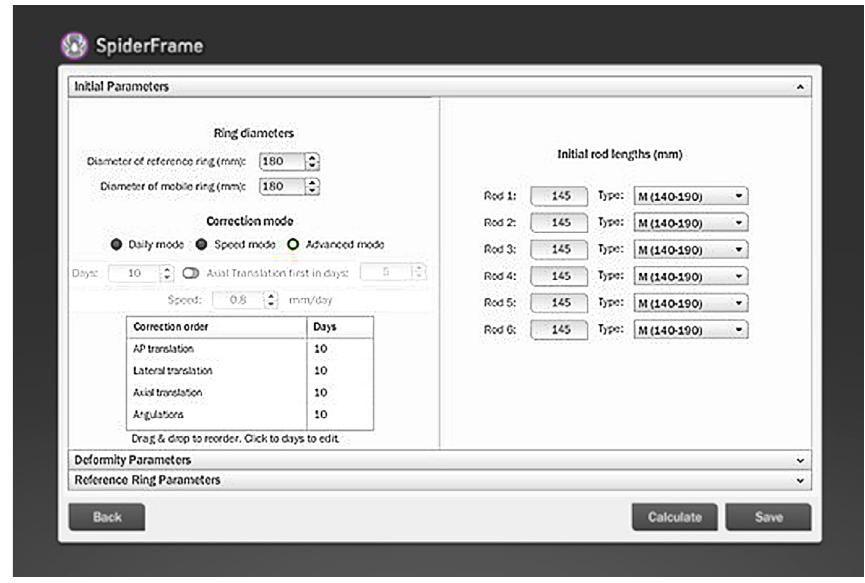
Figure 1. Spider Frame correction